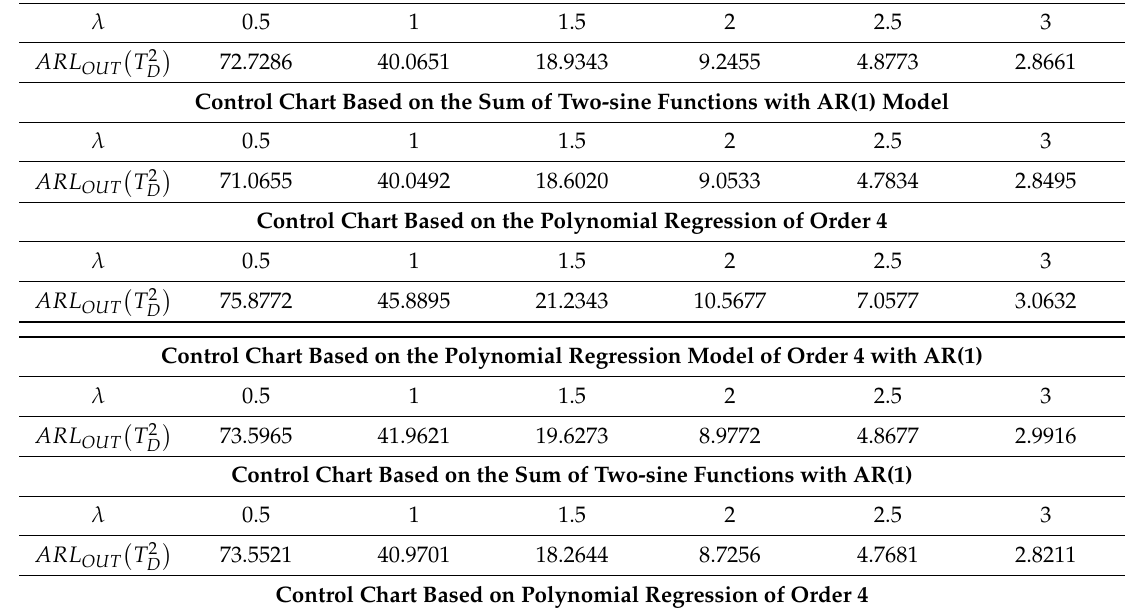
; ( b ) b 1 from b 1 to b 1 + λσ b 1